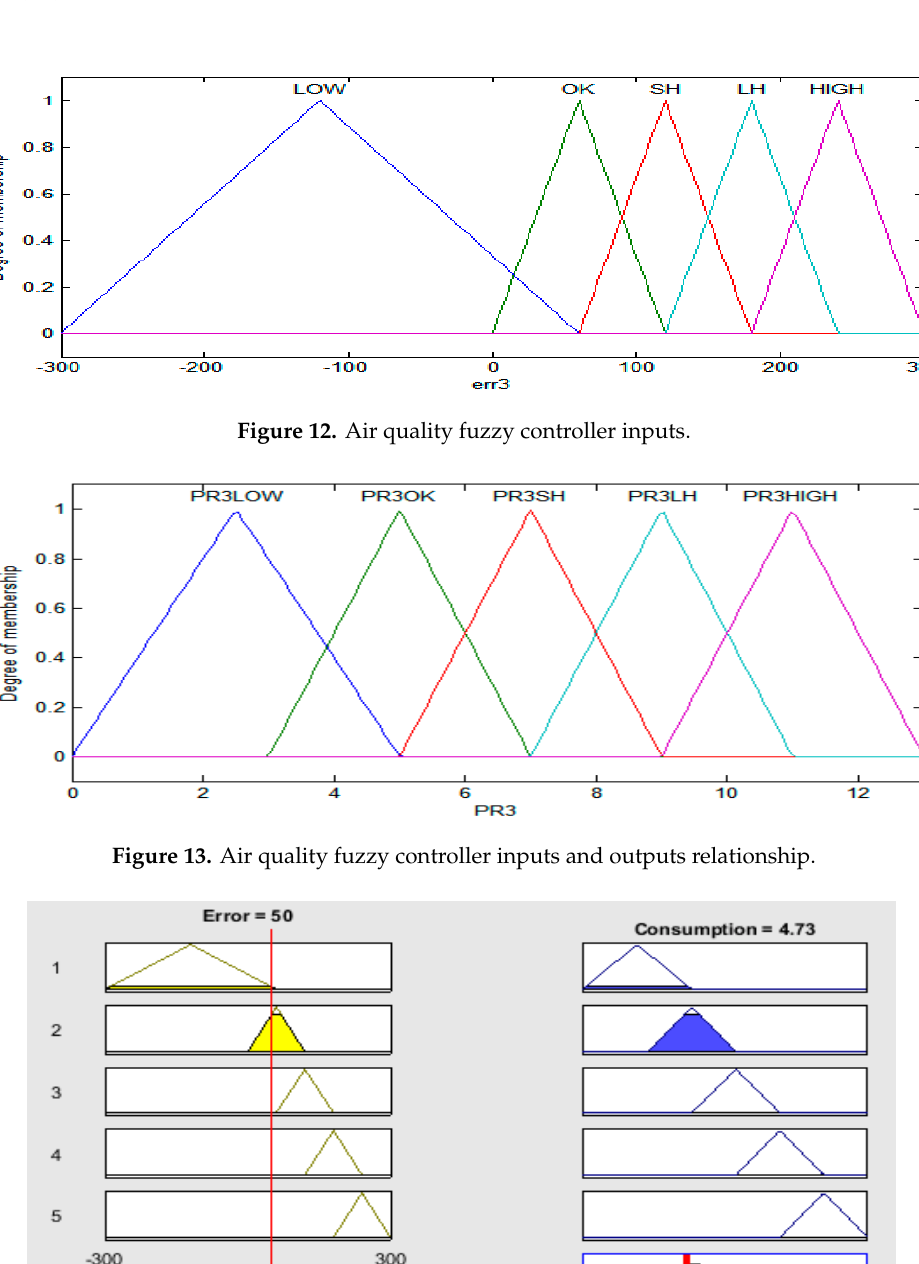
Figure 11. Power consumption for the air quality based on the considered approaches.